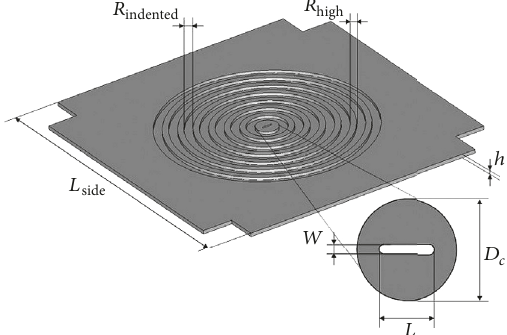
Figure 7: The “Bull’s Eye” antenna